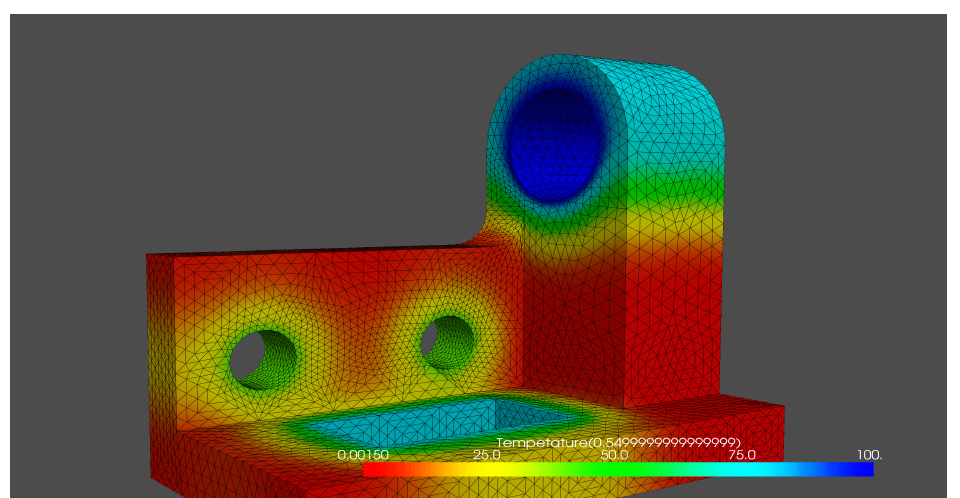
Figure 8. Temperature contour of a function space of order 1 at t = 0.55 s.